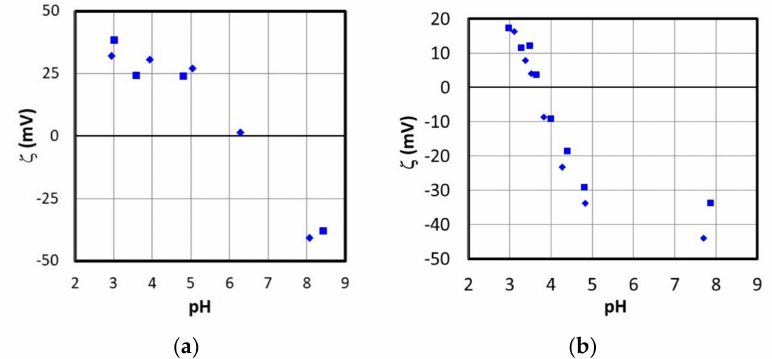
Figure 8. Zeta-potentials of TiO 2 NPs (Samples B and C) and in 1 mM NaNO 3 solutions. ( a ) TiO 2 Sample B. ( b ) TiO 2 Sample